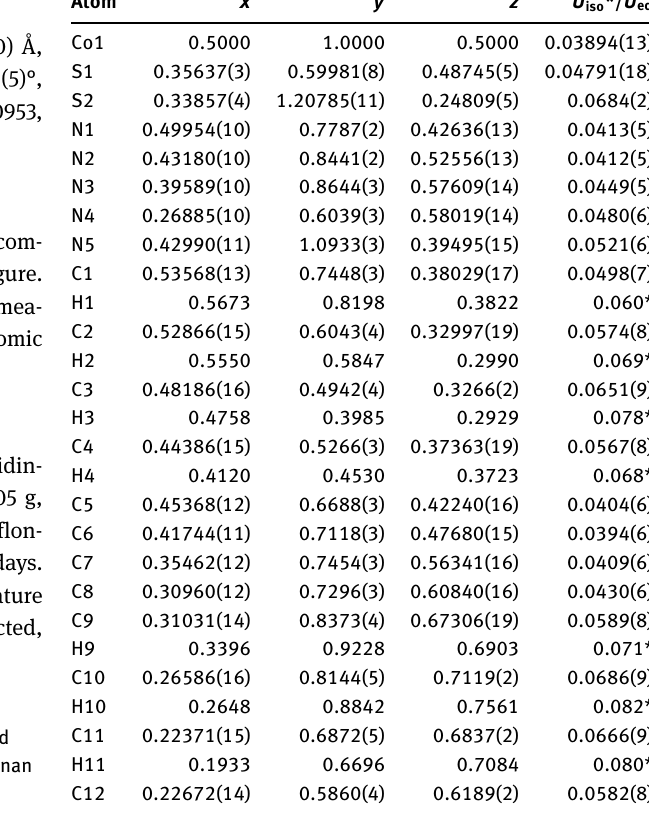
Table 2: Fractional atomic coordinates and isotropic or equivalent isotropic displacement parameters (Å 2